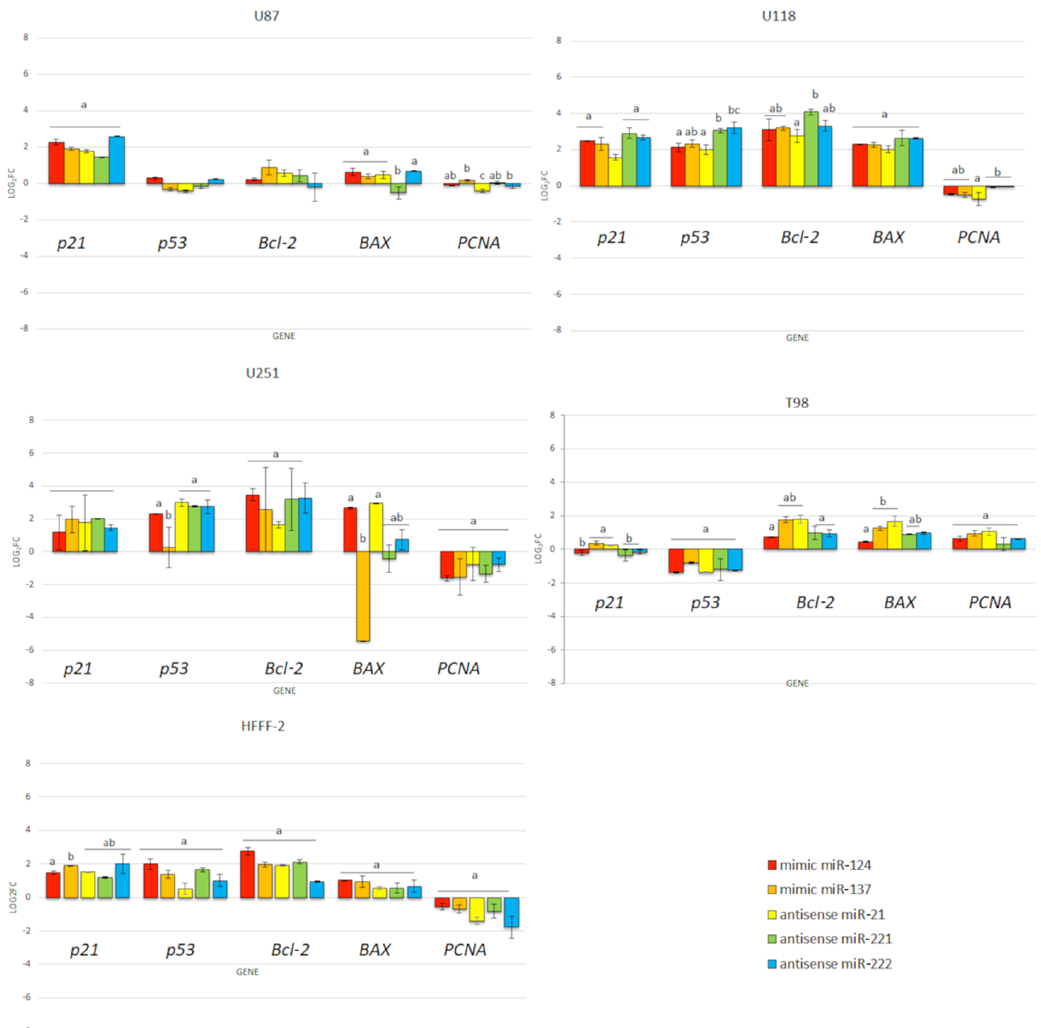
Figure 12. Expression of genes p21, p53, Bcl-2, BAX and PCNA at the mRNA level in U87, U118, U251 and T98 glioblastoma and HFFF-2 fibroblast cells 24 h post transfection by electroporation using RT-PCR. Bars represent means with standard deviation (SD) ( n = 3). Relative expression was calculated using the gapdh gene and the control group (0). The results are presented as log 2 FC values. Values above/below 0 indicate upregulation/downregulation of gene expression. FC fold change. Notes: Different lowercase letters (a, b) within columns indicate significant differences between the miRNA ( p < 0.05).